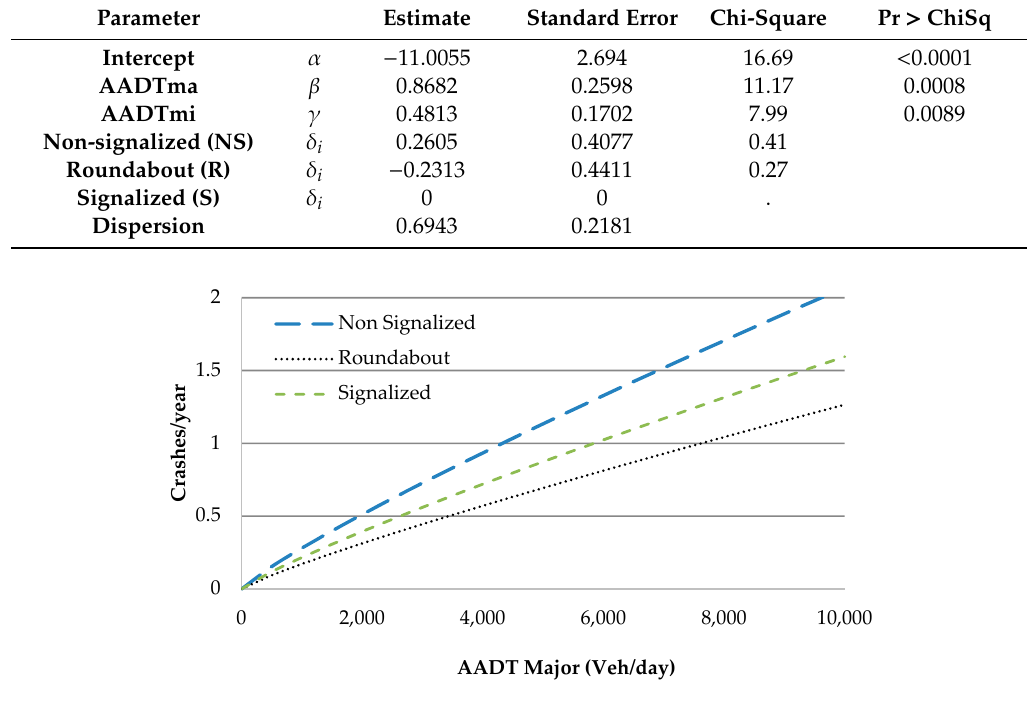
ff erent intersection Figure 4. SPF diagram for different intersection types. Figure 4. SPF diagram for di